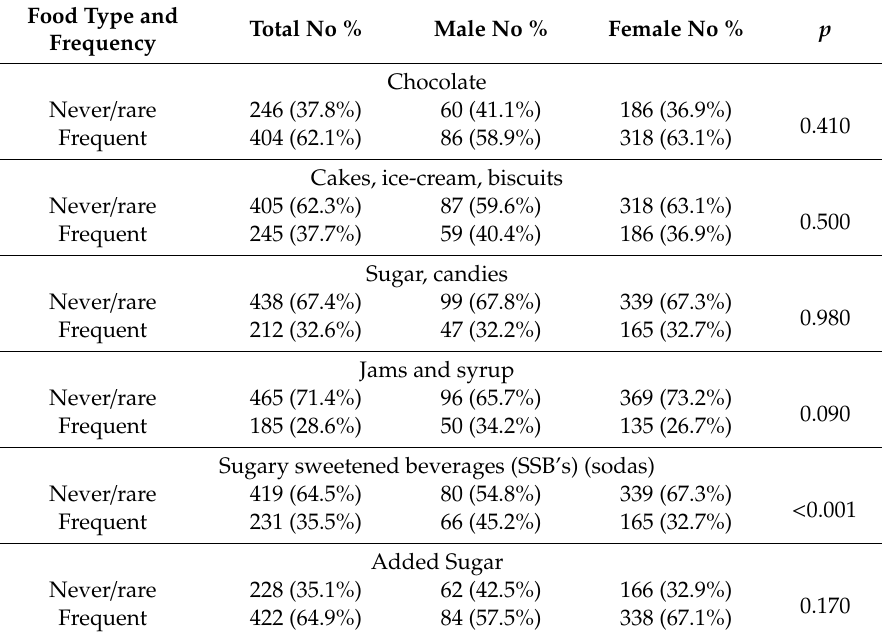
Table 3. Dietary behaviors of the studied sample. Use of sugary food (type and frequency).